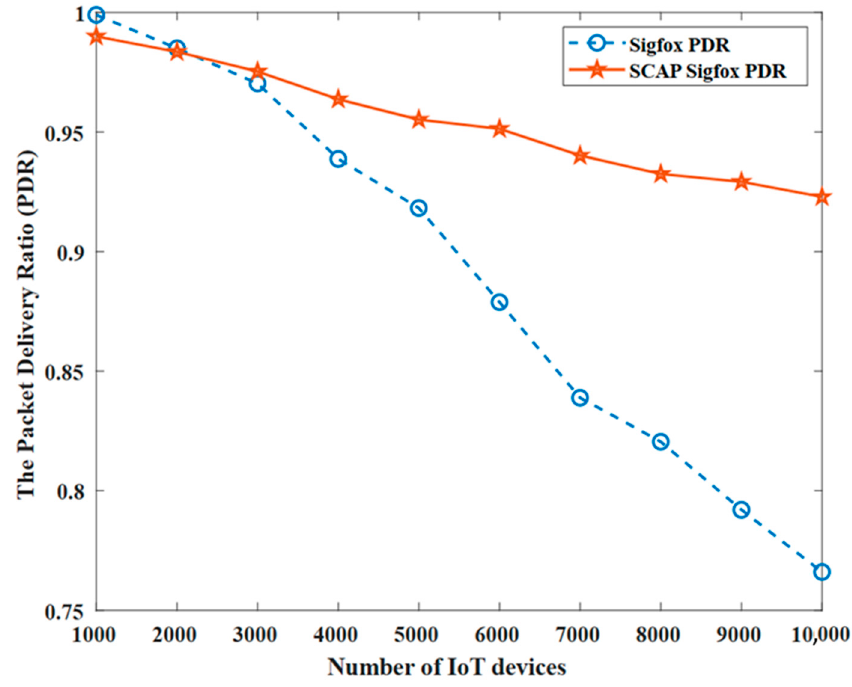
Figure 10. The packet delivery ratio (PDR).